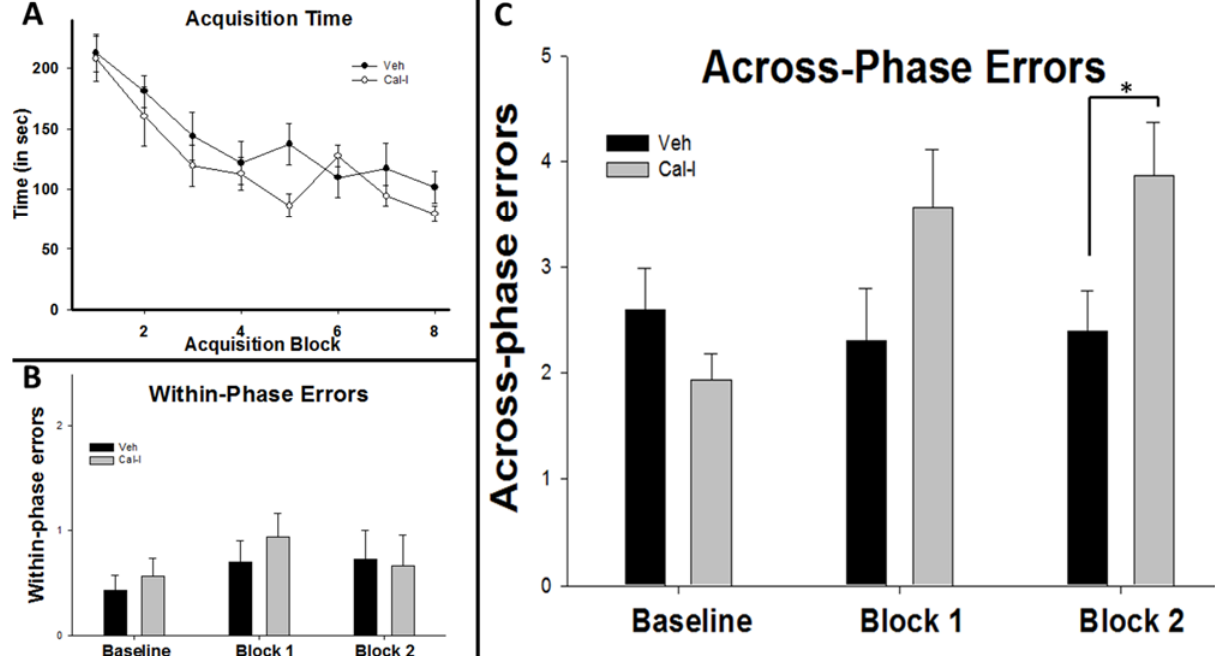
Figure 4. Chronic calpain inhibition impairs spatial working memory formation in the RAM. Animals in both groups acquired the task ( A ) with both groups showing pre-surgery latencies that were not significantly different overall or on block 7 or block 8. Post-surgery, there were no differences between Veh and Cal-I groups for within phase errors ( B ); but a significant increase in across-phase errors for the Cal-I group was seen ( C ) compared to Veh controls. * p <